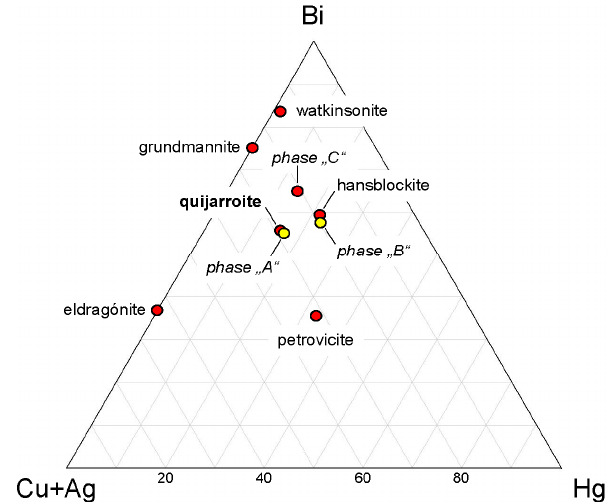
Figure 5. (Cu + Ag) − Hg − Bi ( % apfu ) ternary diagram showing the mean compositions of minerals of the Cu − Hg − Pb − Bi − Se system from El Dragón. Note the correspondence of quijarroite with phase “A” and hansblockite with phase “B” within analytical error. Data sources: [4,5], this paper and [2], for phases “A” and “B”.